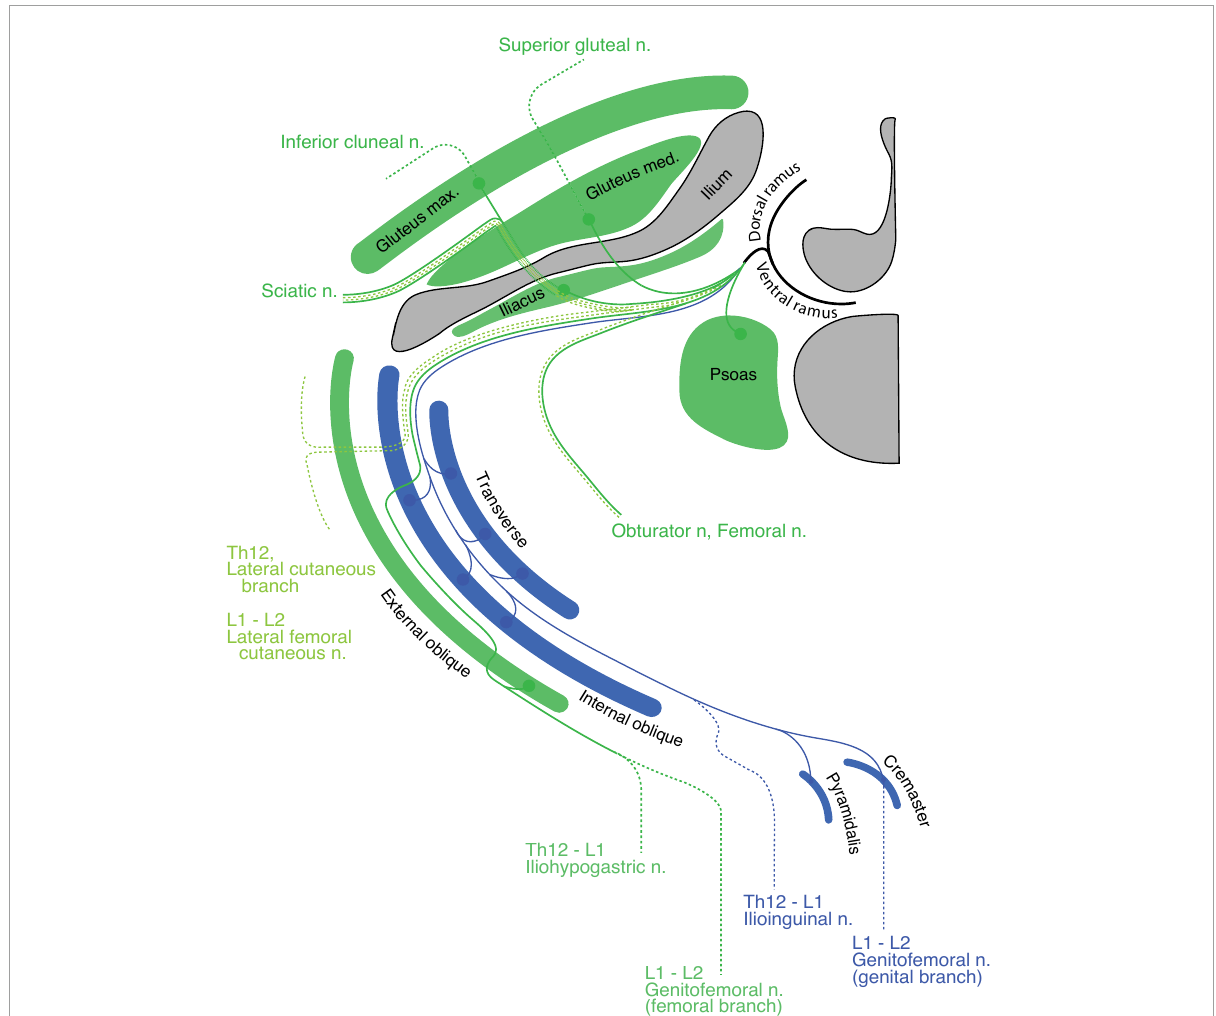
FIGURE10 Hypothetical innervation pattern in the upper lumbar region. Nerve branches are super-imposed on a hypothetical single plane; therefore, not all of them necessarily exist on the same transverse plane. The named nerve branches are as indicated. The blue color represents the intramural branch and its target muscles. The dark green color is for the extramural branch and its target muscles. The light green color represents the LCB. The dotted segments of the lines are cutaneous branches. The bony structures are shaded in dark